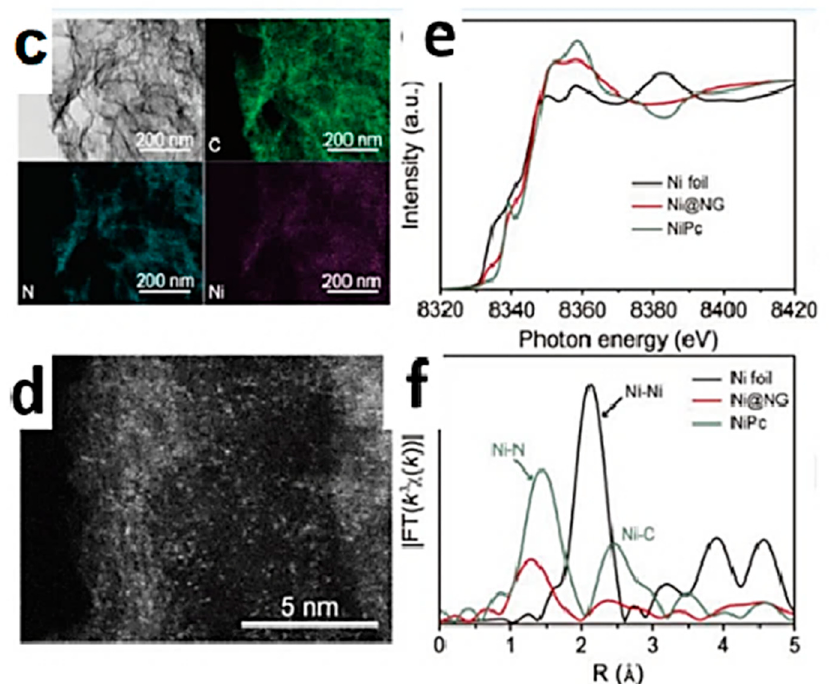
Figure 14. ( a ) Schematic of the synthesis of 3-dimensional N-doped Gp-S composites and ( b ) rate and cyclic performance ( c ) TEM and the corresponding element mapping images of Ni@NG; ( d ) the sub-angstrom resolution HAADF-STEM image of Ni@NG, (bright spots represent single Ni atoms); ( e ) XANES; ( f ) FT - EXAFS spectra Reprinted with permission from [107]. Copyright RSC Publishers, 2014,.